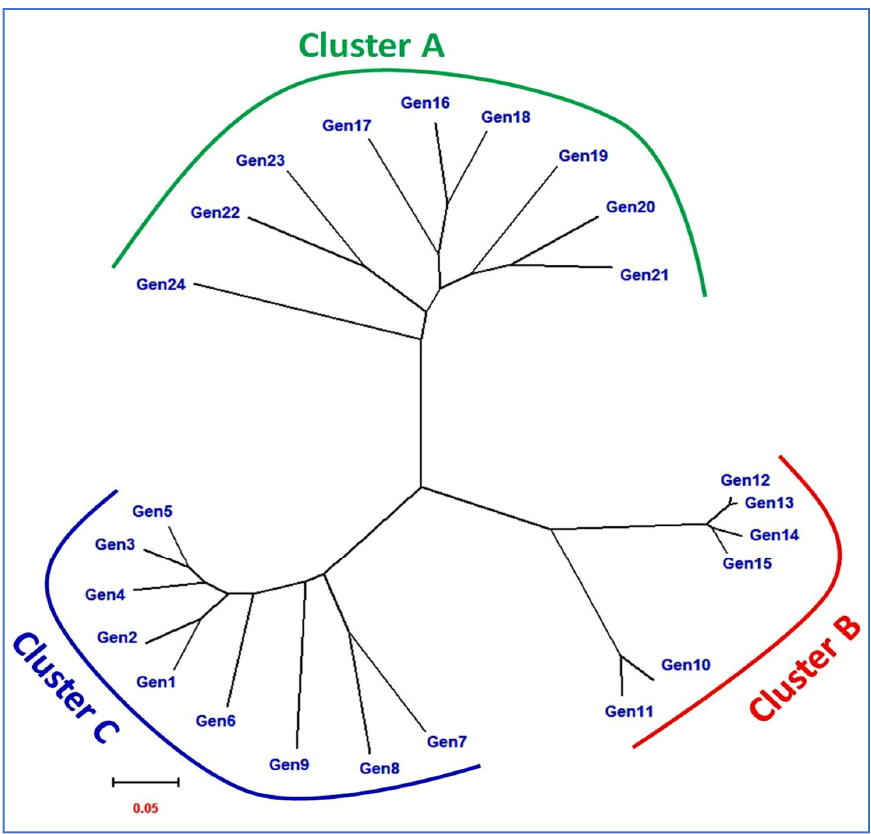
Figure 11. Neighbour joining tree showing the grouping pattern of rice genotypes.